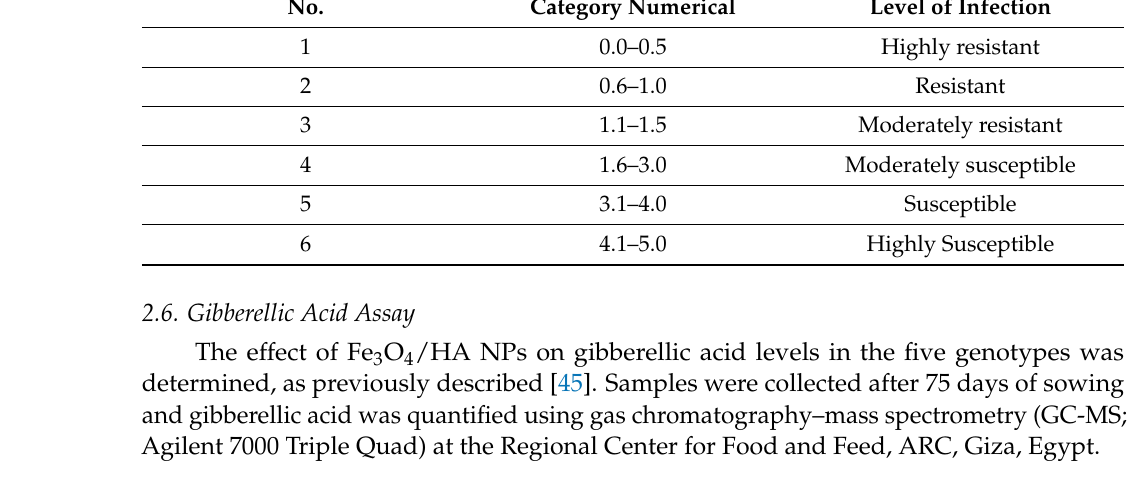
Table 2. Category of A. striticum infestation based on numerical categorization and level of infection.